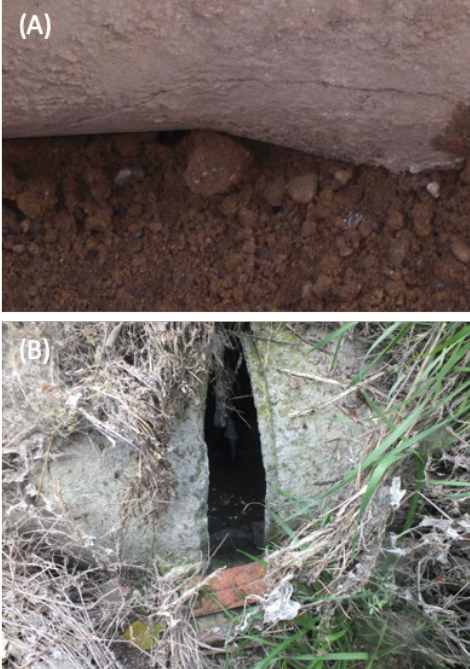
Figure 8. View of breaks in the water and sewer network of Perdiguera: (A) Crack in Del Medio Street Pipe; (B) Break in Main